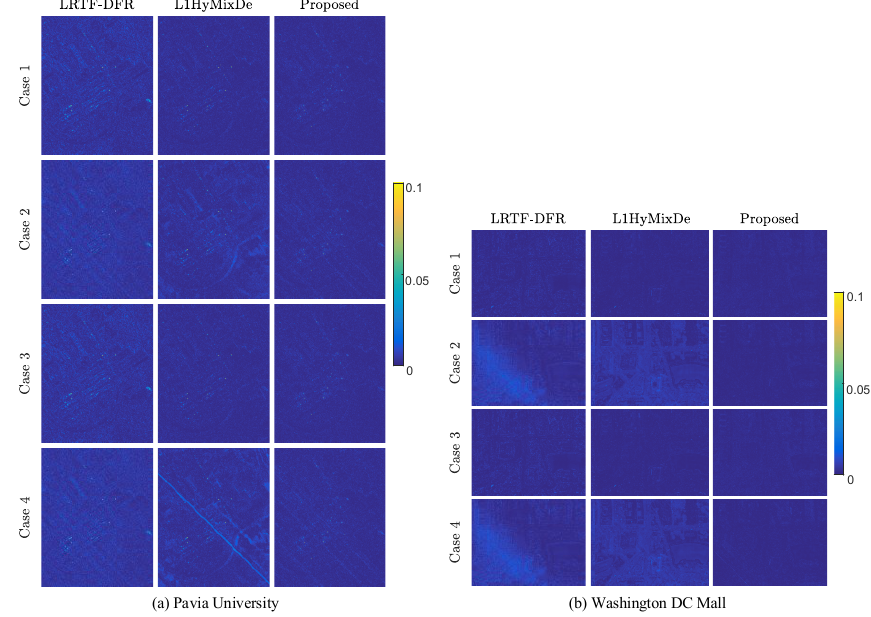
Figure 8. Differences between the clean images and denoised images in four cases for LRTF-DFR, L1HyMixDe, and the proposed method. ( a ) Pavia University data; ( b ) Washington DC Mall